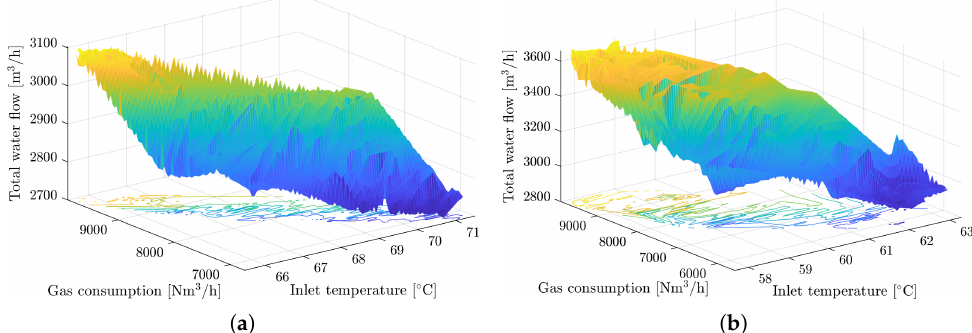
Figure 8. Surfaces depicting the operating areas of MPC (left) and PID (right) control loops. Each axis represents an input to the system: the total water flow, gas consumption, and inlet temperature. This visualization aims to demonstrate that the operating areas for the MPC and PID control loops are similar and thus yield a fair comparison of the performance of both control loops. ( a ) A surface depicting the operating area of the MPC control loop. ( b ) A surface depicting the operating area of the PID control